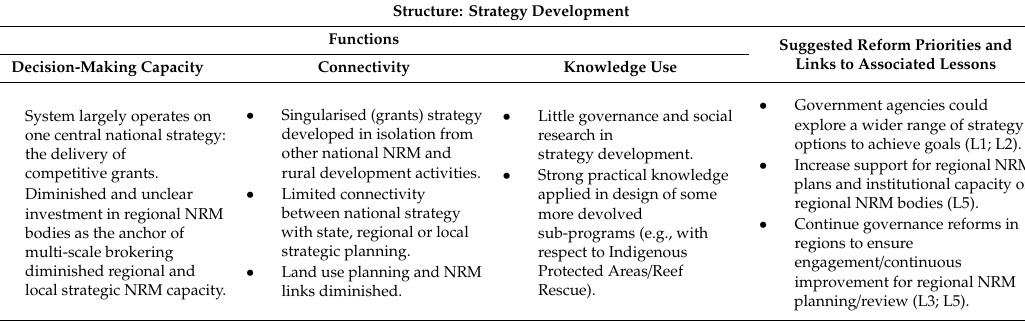
Table 4. A synthesis of findings regarding national aspects of strategy development in Australia’s CBNRM governance